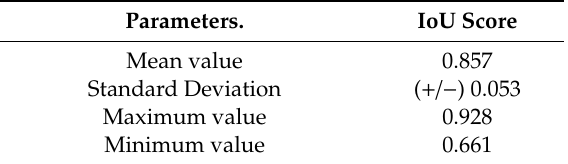
Table 2. Performance of the model for validation set (27 images).